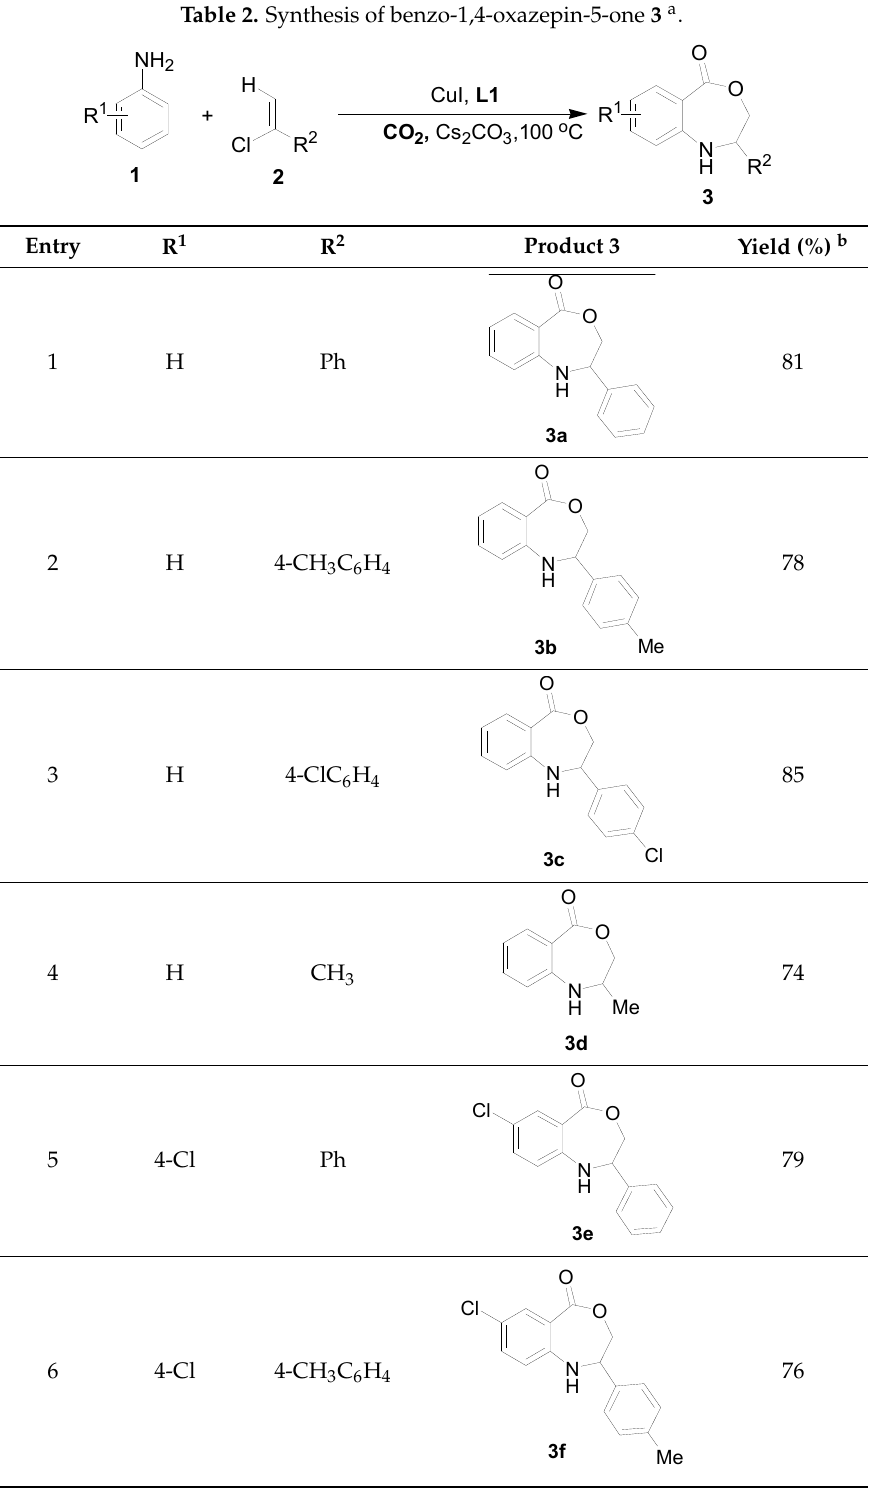
Table 2. Synthesis of benzo-1,4-oxazepin-5-one 3 a .